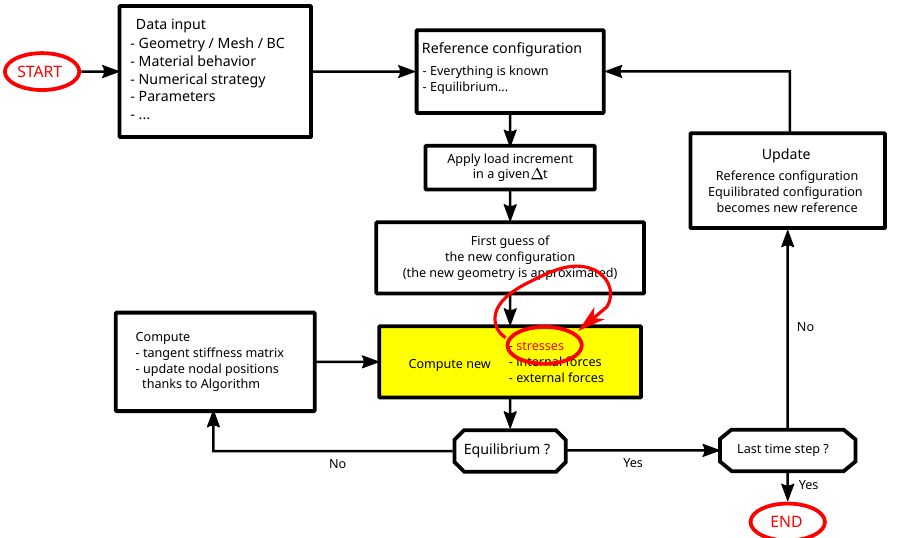
Figure 6. General flowchart of a FE code, focus on the stresses computation using an iterative solving